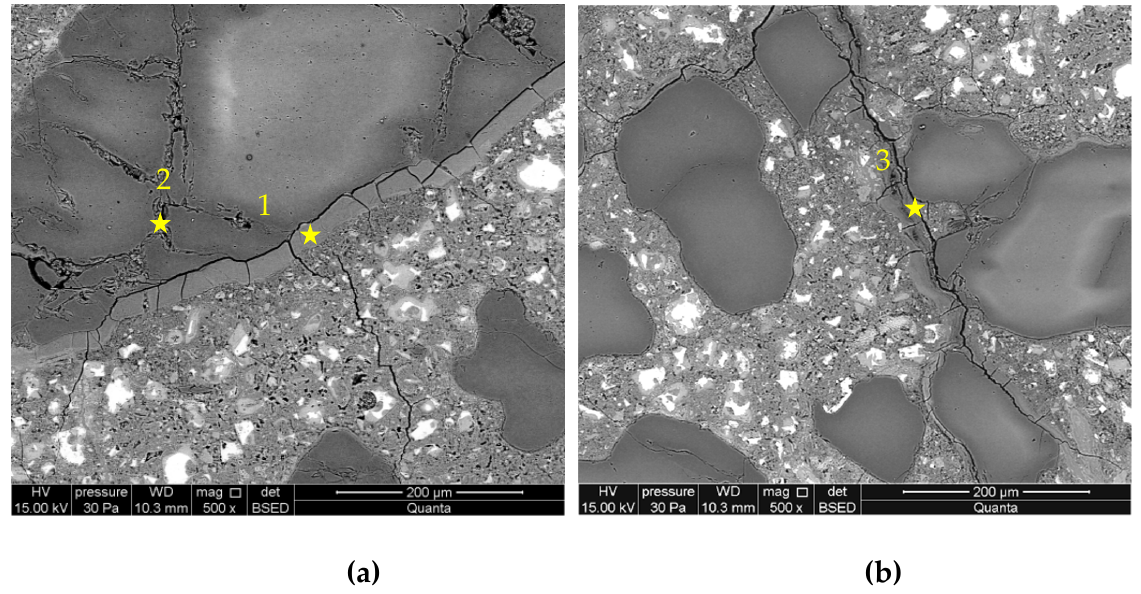
Figure 7. Microstructure images of mortars with 5% of metakaolin: ( a ) ASR gel in aggregate and ITZ; ( b ) ASR gel in cement paste. X-ray microanalysis at location 1 – 3 (see Table 4).